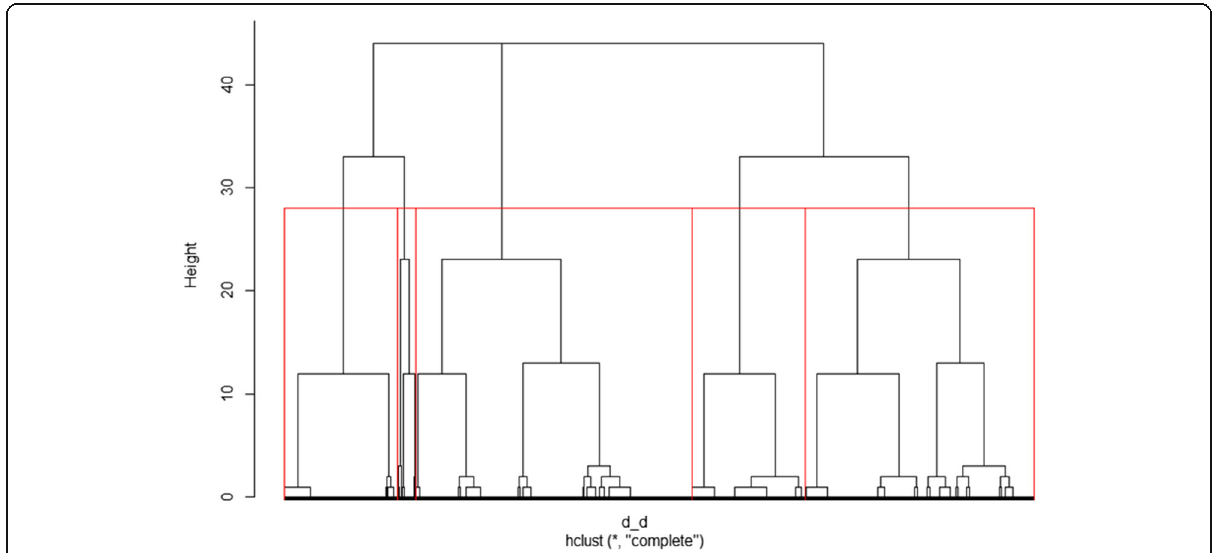
Fig. 7 Dendrogram of the hierarchic cluster analysis